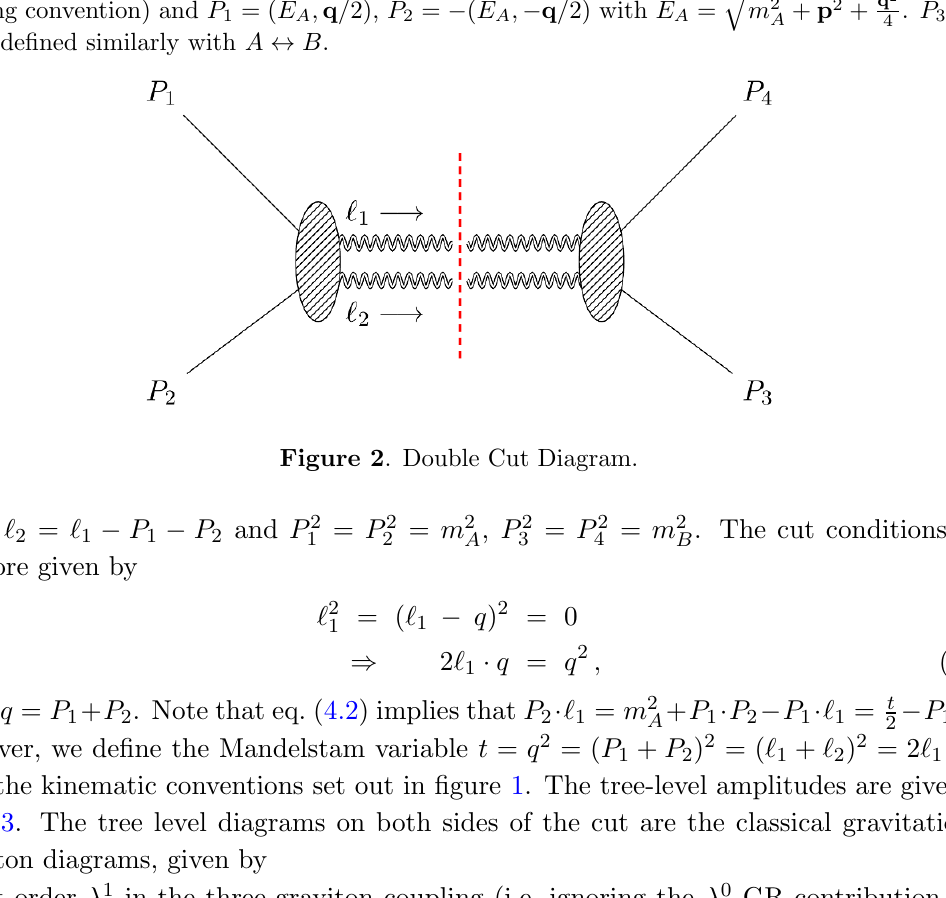
q m 2 + p 2 + q 2 . P 3 and A 4